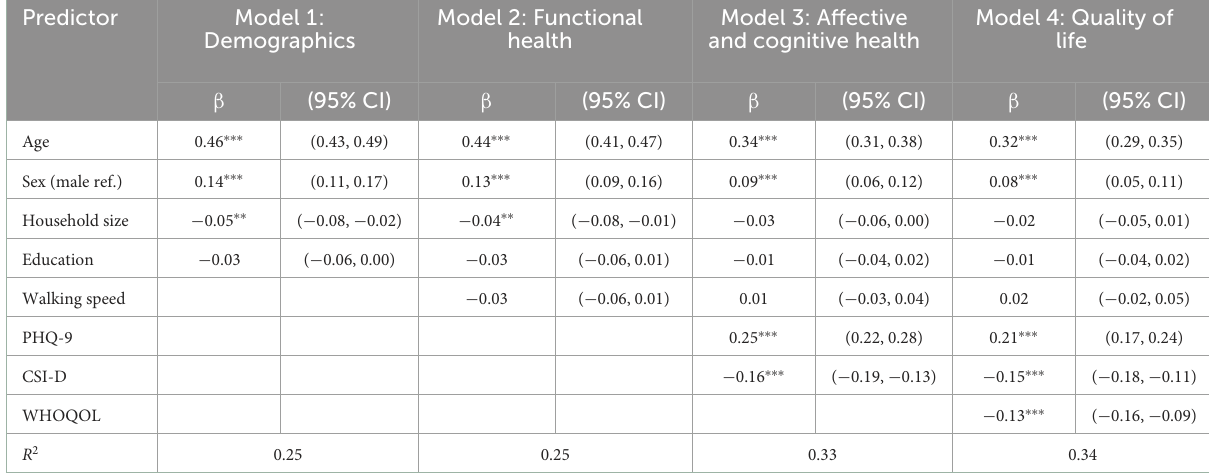
TABLE 3 Hierarchical regression for the association of health variables to AARC-losses as an outcome (Burkina Faso sample; N = 3,028).